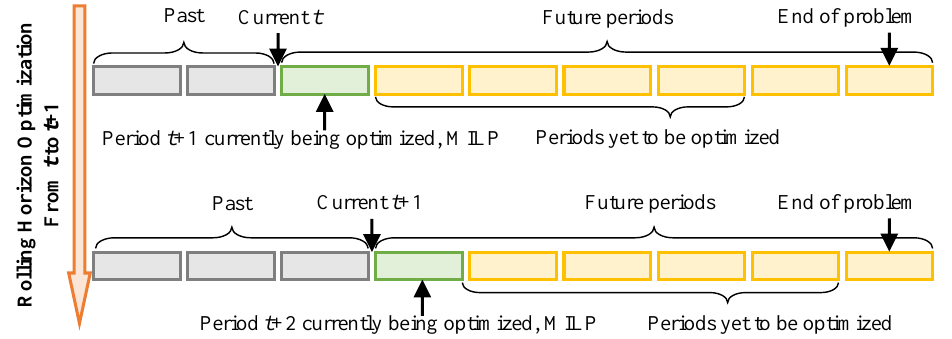
Figure 3. Schematic representation of the rolling horizon optimization from time t to time t +